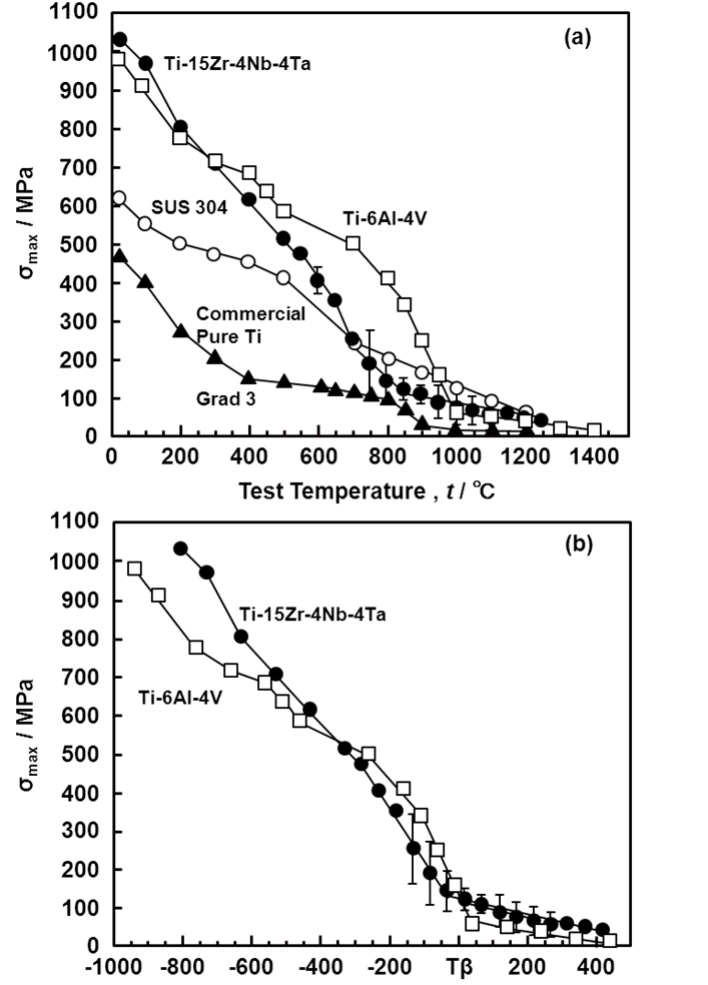
Figure 17. Effect of test temperature on σ ( a ) Effect of test temperature on σ and test temperature of tensile test.